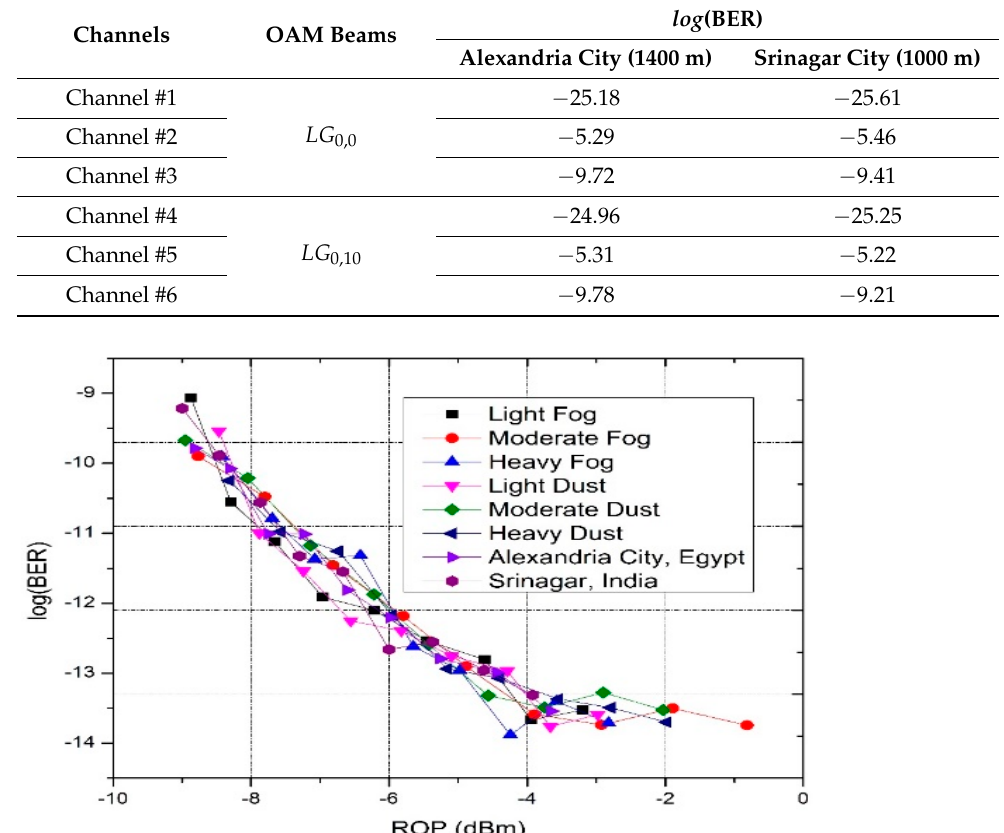
Figure 12. Log (BER) versus ROP under foggy, dusty, and Alexandria and Srinagar cities’ weather conditions. Table 9. Comparison between different multiplexing techniques used in previous work and present work.